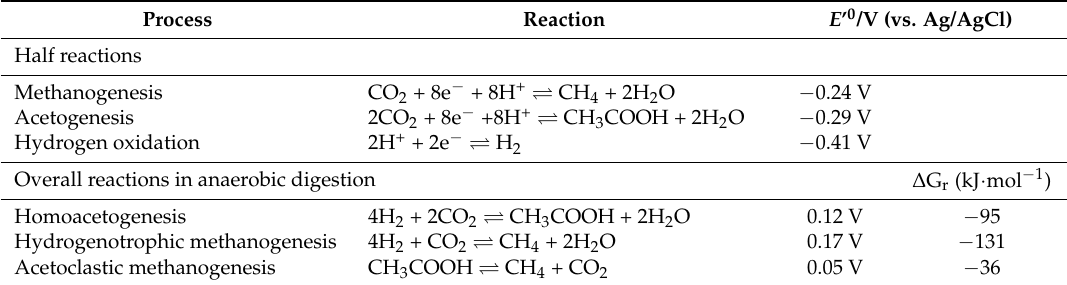
Table 1. Overview of reactions involved in methanogenesis and homoacetogenesis by reduction of CO 2 . Depicted are both half reactions (upper) and overall reactions using hydrogen or acetate as an electron donor. Standard reaction energies/potentials were taken from Thauer et al. [12] and expressed at pH 7, 298 K with all other reactants at standard